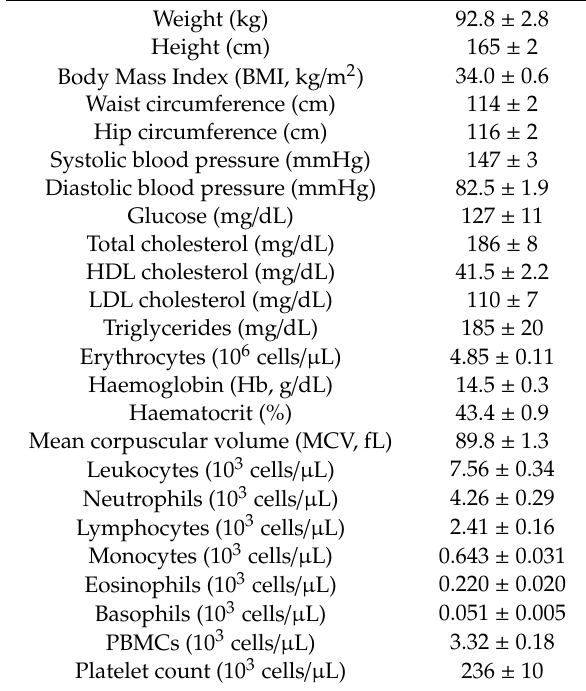
Table 2. Anthropometric, hematological, and biochemical characteristics of